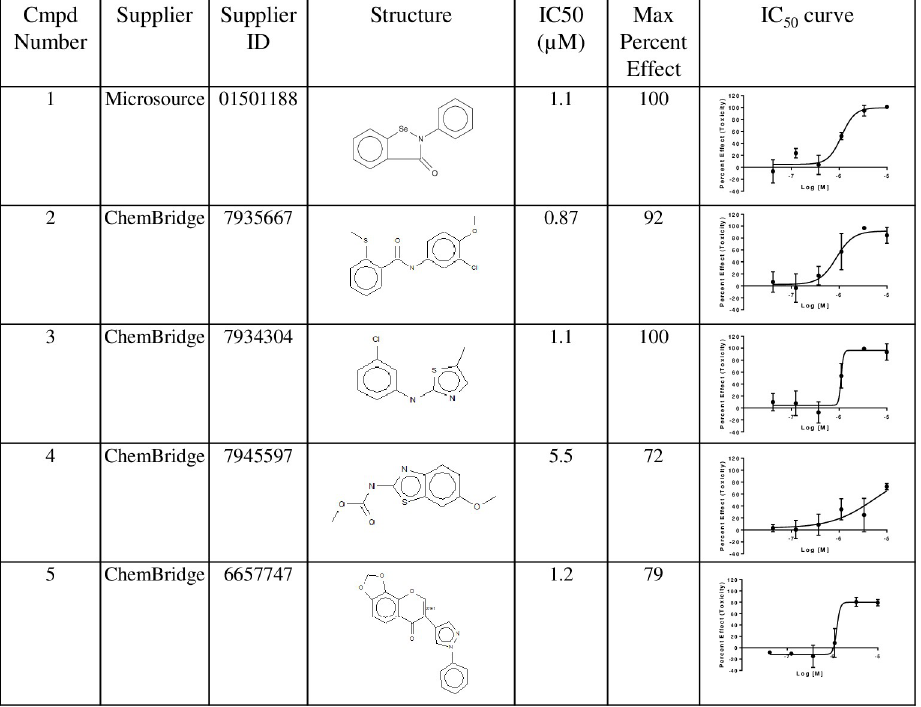
Fig 6. Top 5 most active non-benzimidazole related compounds identified by HTS screening.